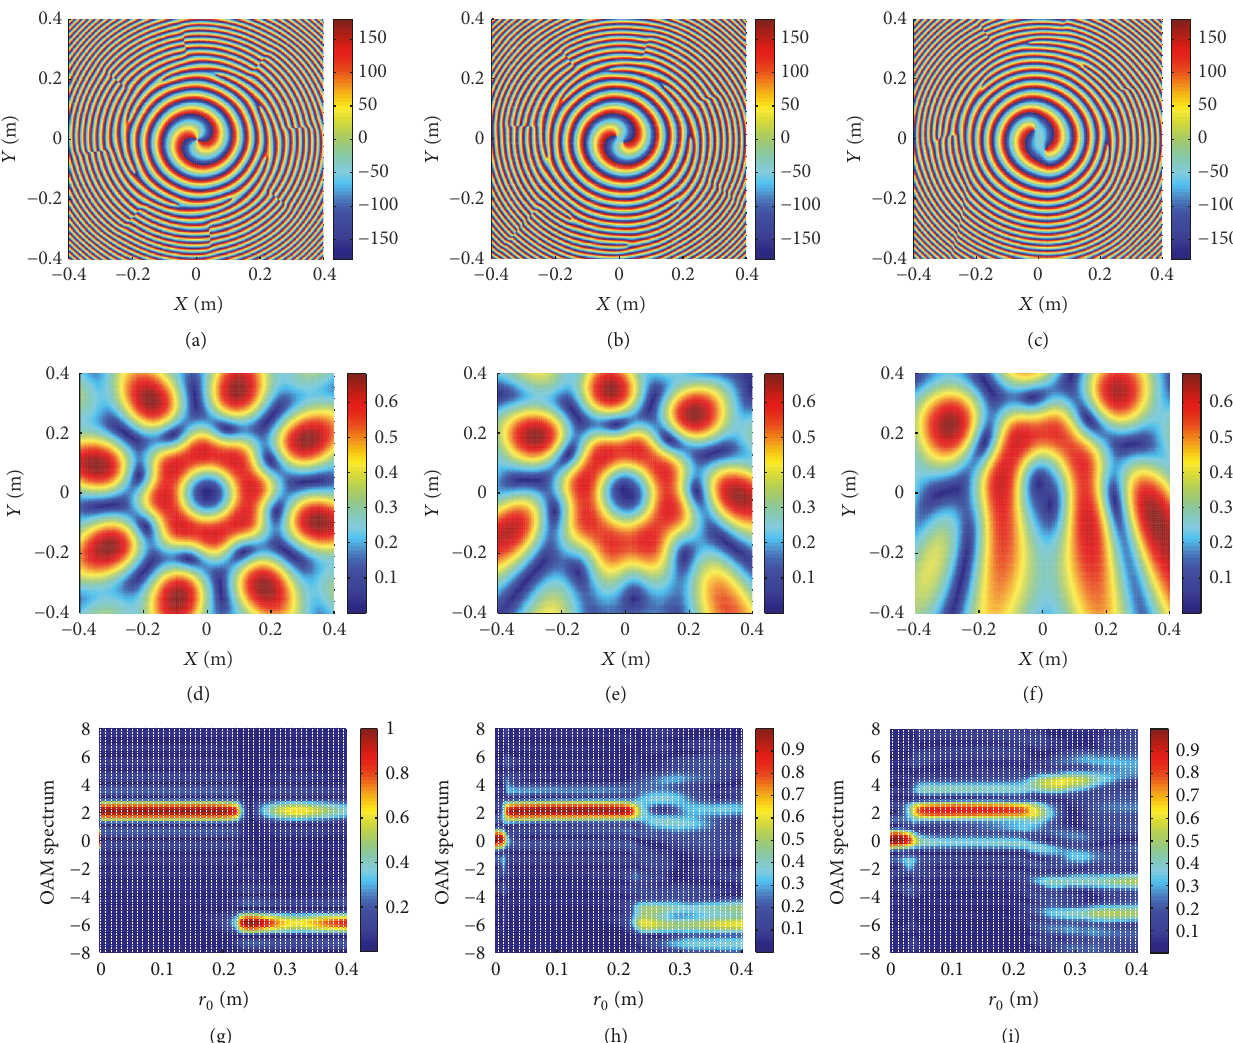
Figure 3: Phase profiles (a, b, c), intensity patterns (d, e, f), and the OAM spectrum (g, h, i) after utilizing radio OAM steering in three different directions. (a, d, g), (b, e, h), and (c, f, i) refer to the steering angles ( 0 ∘ ,60 ∘ ), ( 30 ∘ ,60 ∘ ), and ( 60 ∘ , 60 ∘ ),